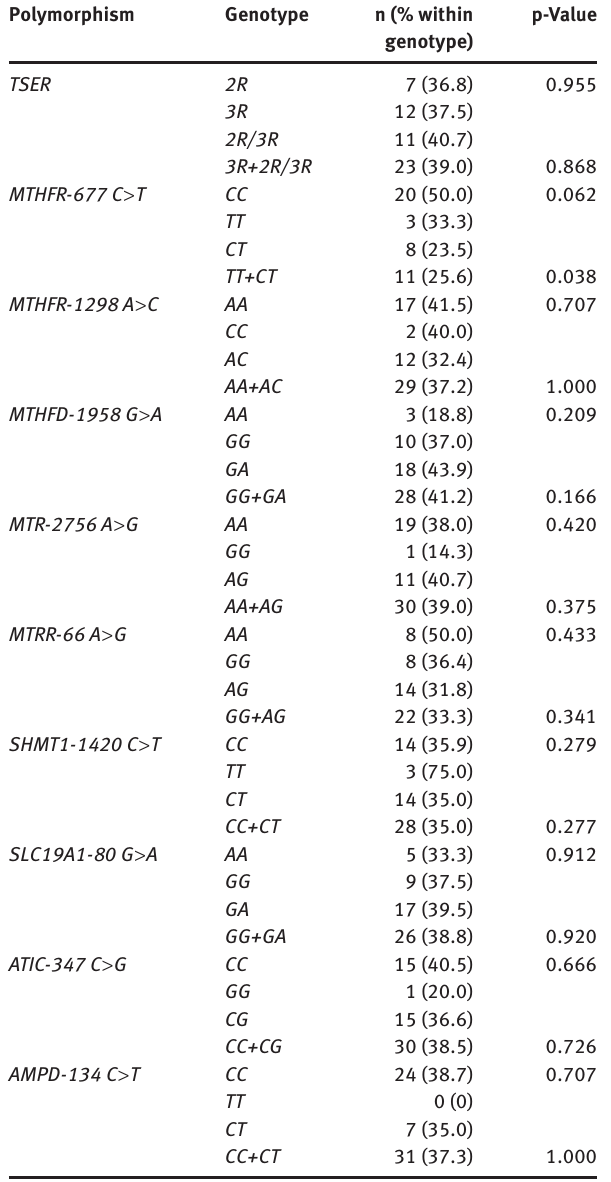
Table 5 Blood and bone marrow grade 3-4 toxicity by